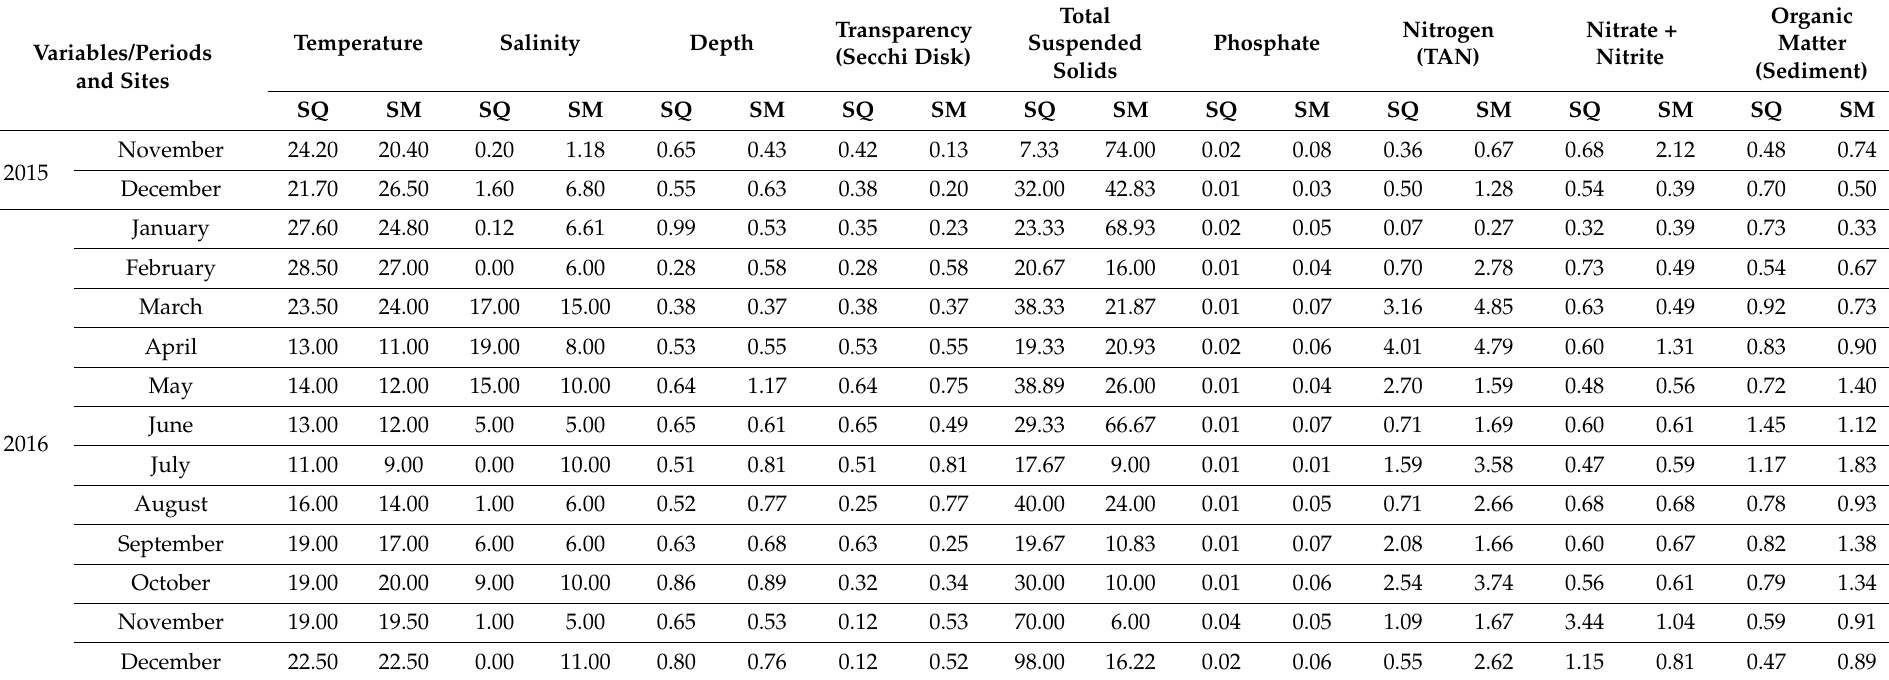
Table 1. Values of environmental variables (temperature ( ◦ C), salinity (‰), depth, transparency (m), total suspended solids, phosphate, total ammo- niacal nitrogen (TAN), nitrate + nitrite (mg L − 1 ) and organic matter in the sediment (%)) during the study period (November 2015 to February 2018). SQ = Saco da Quit é ria, SM = Saco da